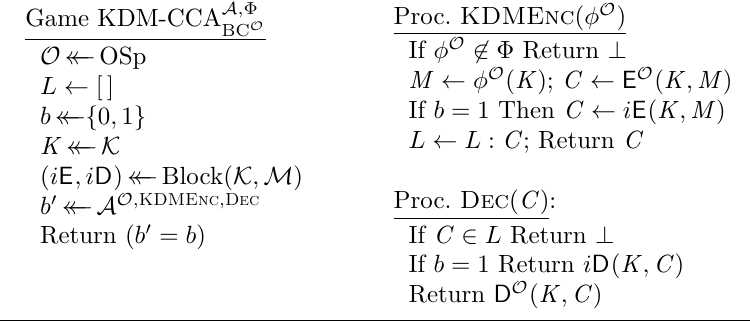
Figure 3: Game defining Φ-KDM-CCA security for a